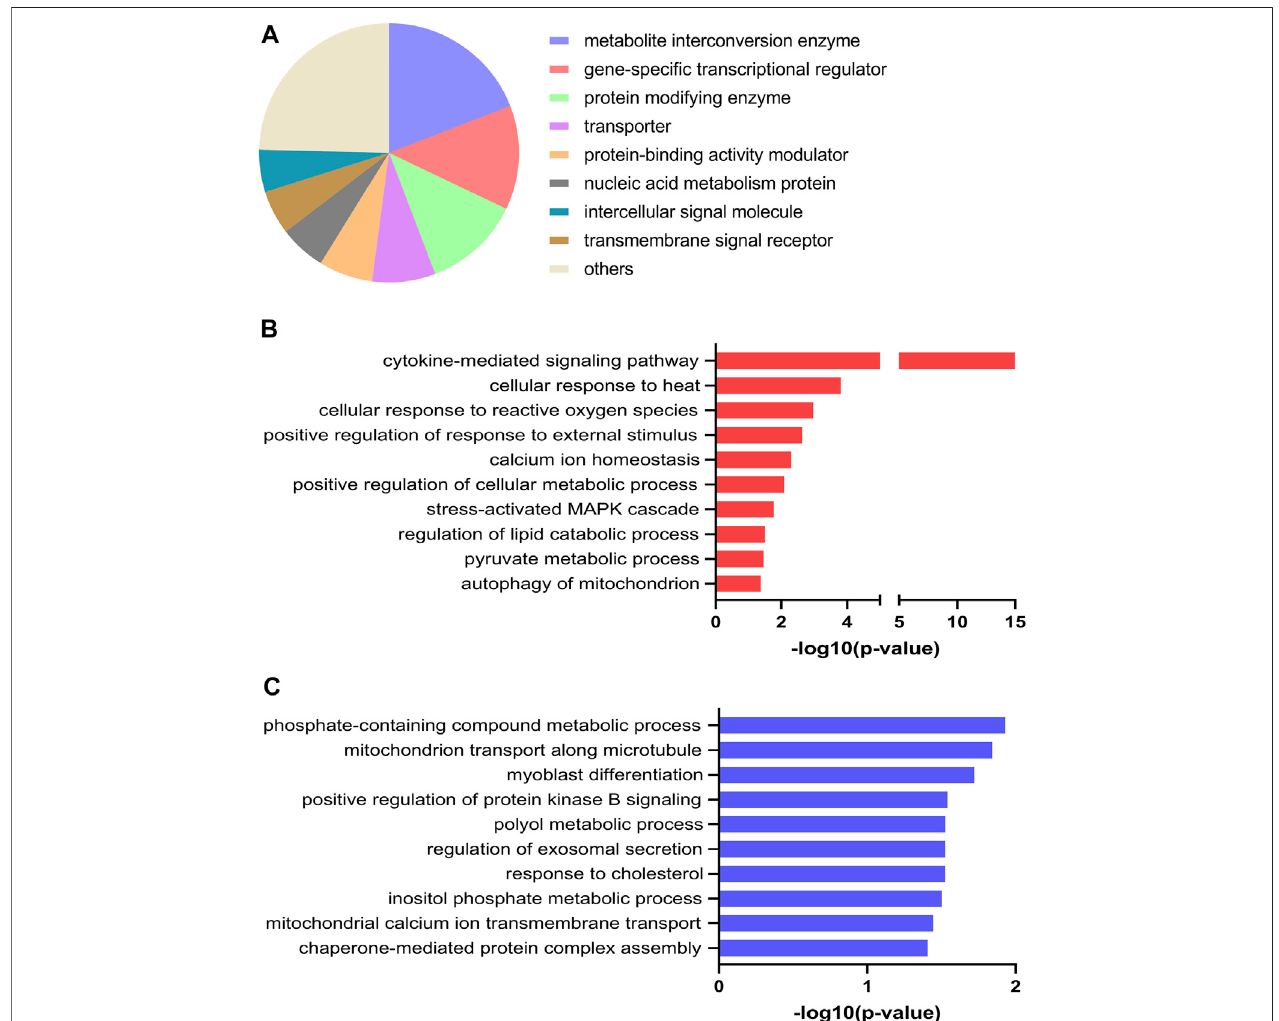
FIGURE 4 | Protein class and selected Gene Ontology (GO) enrichment of differentially expressed genes (DEGs) for electrical pulse-stimulated (EPS protocol 1) versusunstimulated controlmyotubesfromyoungmalesubjects. (A) ProteinclassesofDEGs. (B) SelectedGObiologicalprocessesenrichedforupregulated DEGs (C) Selected GO biological processes enriched for downregulated